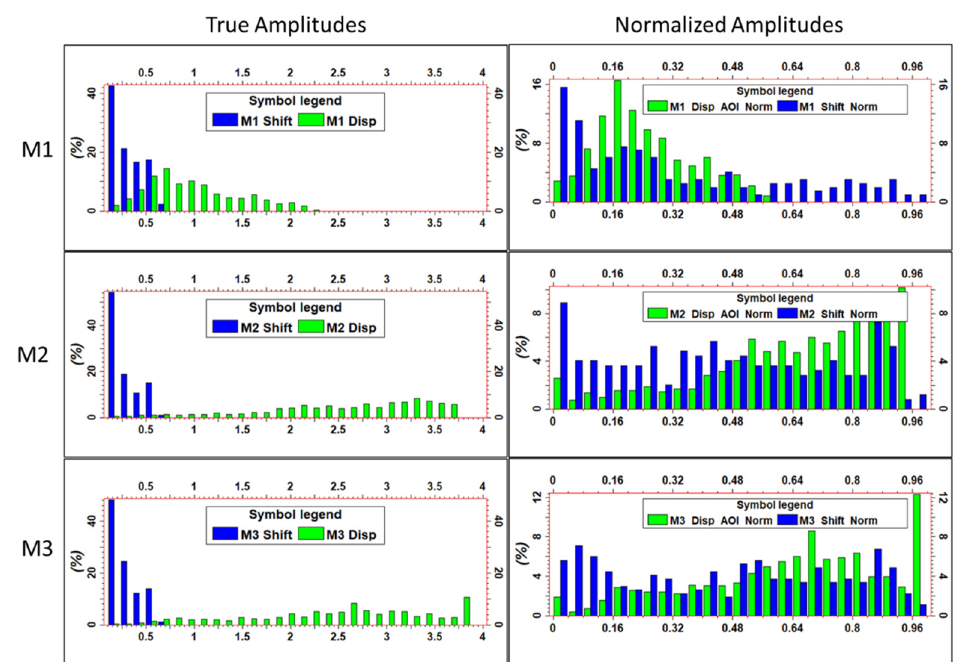
Figure 21. Magnitude distributions of simulated time-lapse depth shifts (blue) and Schlumberger Displacement attribute computed from VSP data (green) for monitor surveys M1 ( top ), M2 ( Mid ), and M2 ( bottom ). and M3. Data in the left column is true amplitude. Data in the right column has been normalized to the maximum observed value for each data type.